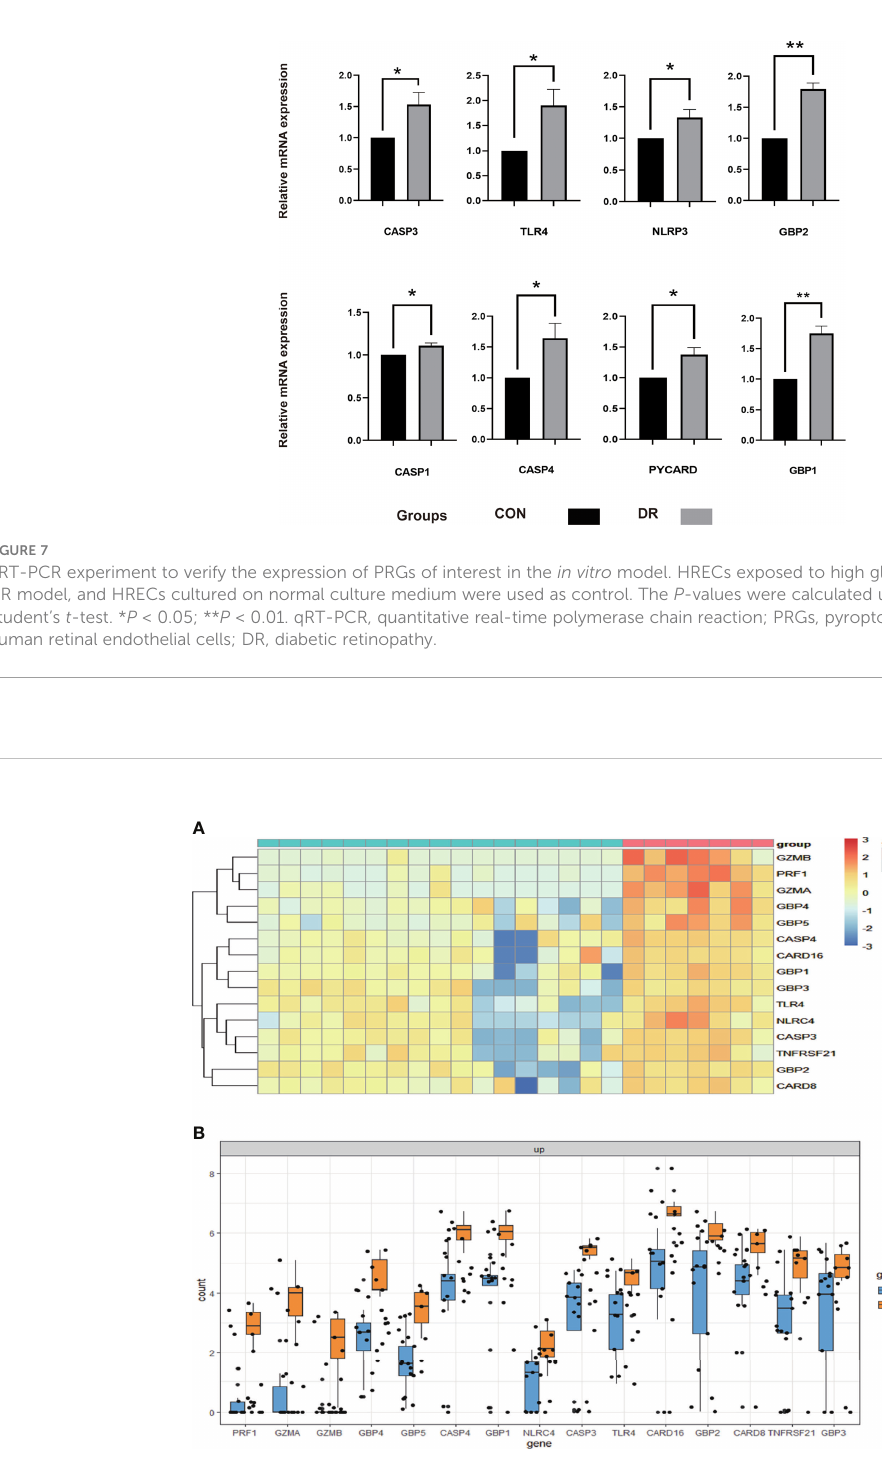
FIGURE 8 Validation of PRGs in the GSE179568 dataset. (A) Heatmap of 15 differentially expressed PRGs in the GSE60436 dataset. (B) Box plot of 15 differentially expressed PRGs in the RNV membranes of PRD patients and in the epiretinal membranes of macular pucker and macular hole samples. Adjusted P -value <0.05 and |log 2 fold change| >1.0. PRGs, pyroptosis-related genes; RNV, retinal neovascularization; PDR, proliferative diabetic